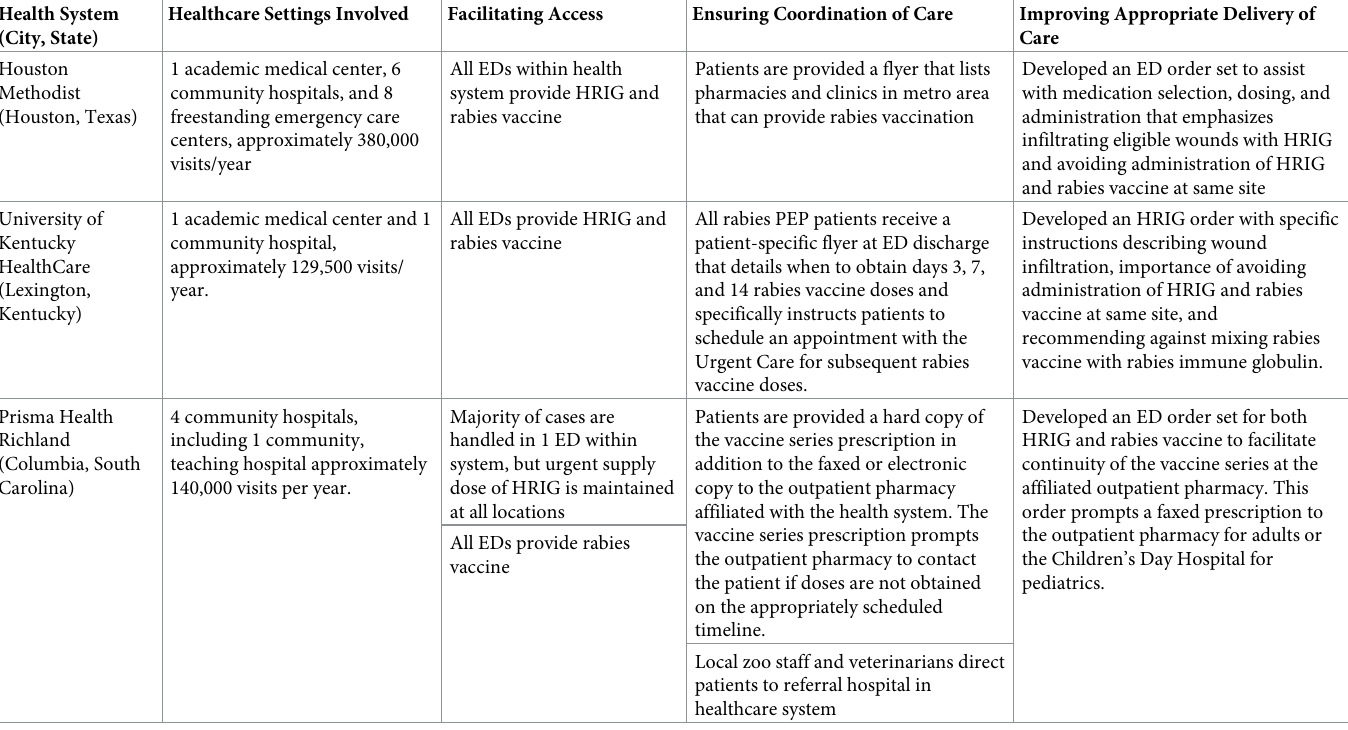
Table 1. Examples of rabies PEP quality programs in the